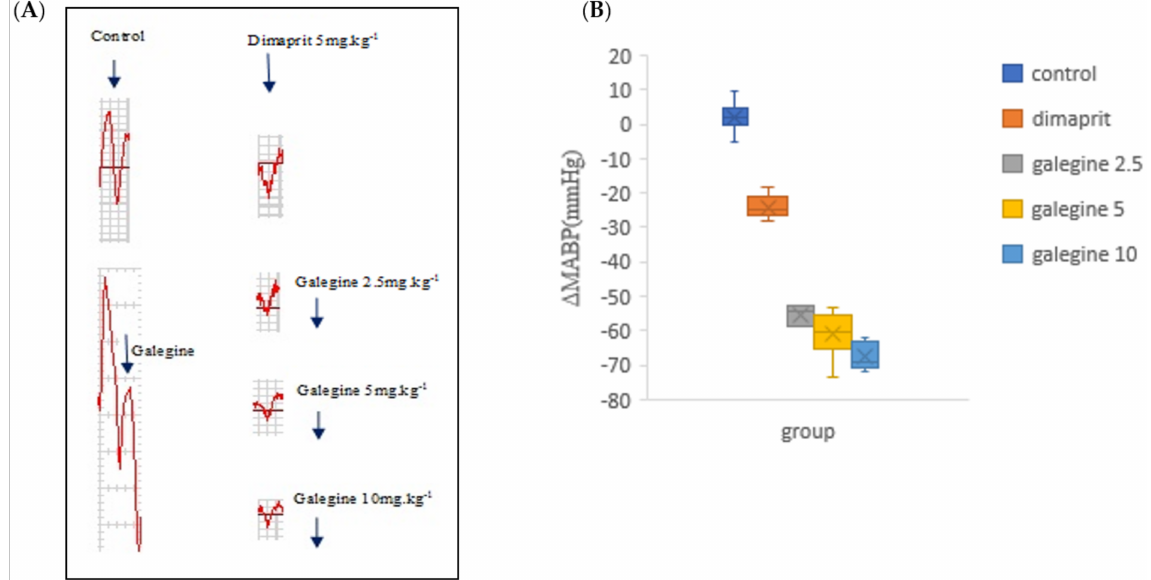
Figure 4. Influence of dimaprit and galegine on pentobarbital-anesthetized hypertensive rats MABP. ( A ) Representative raw traces of rat arterial blood pressure (ABP) following dimaprit or galegine infusion (blue arrow with doses used) compared to the control group. As expected, protocol assessment molecules dimaprit (5 mg · kg − 1 ) and galegine (2.5 mg · kg − 1 , 5 mg · kg − 1 , 10 mg · kg − 1 ) induced ABP, respectively. ( B ) Box and whisker plots of ∆ MABP data in the control, dimaprit and galegine group following i.p. injections, 5 mg · kg − 1 for dimaprit and 2.5 mg · kg − 1 , 5 mg · kg − 1 , 10 mg · kg − 1 for galegine, respectively.